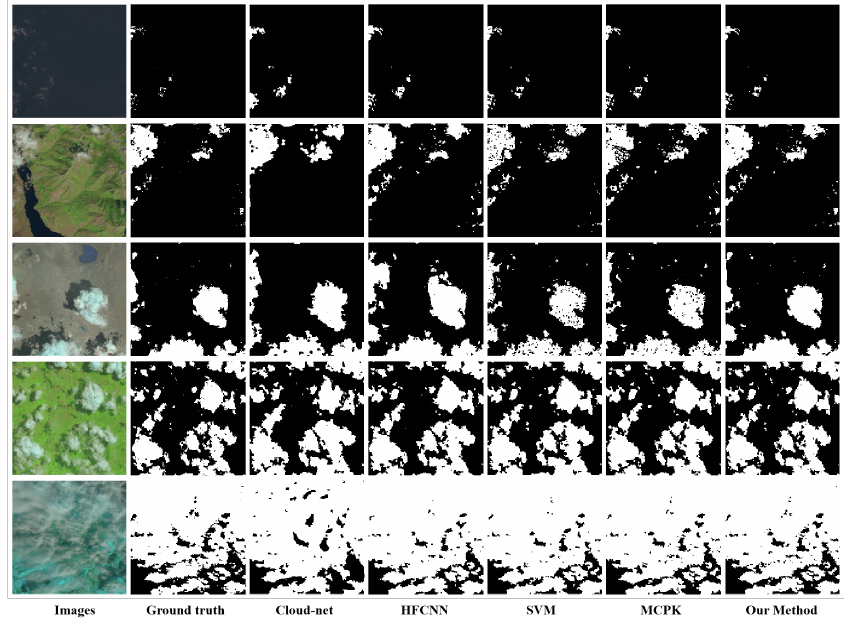
Figure 5. The performance of several methods on Cloud-38 dataset [33] with different cloud distribu- tion